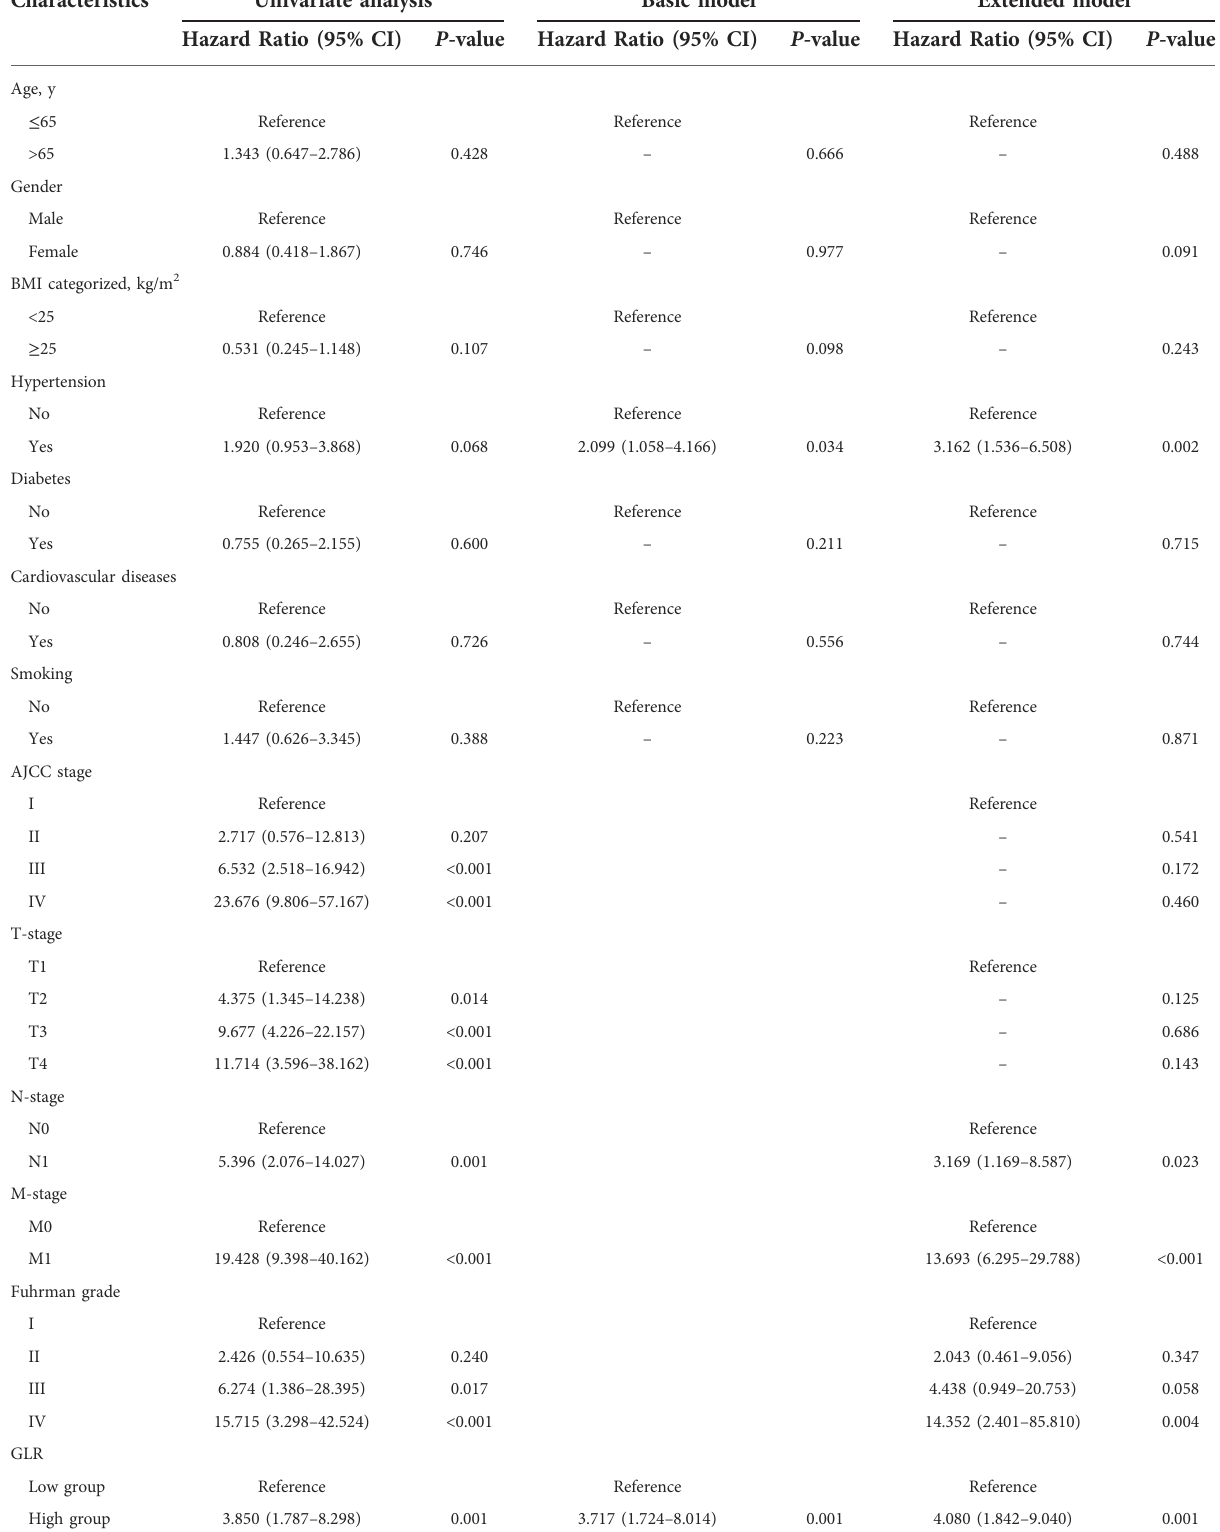
TABLE 3 Univariate and multivariate analyses of factors associated with cancer-speci fi c survival